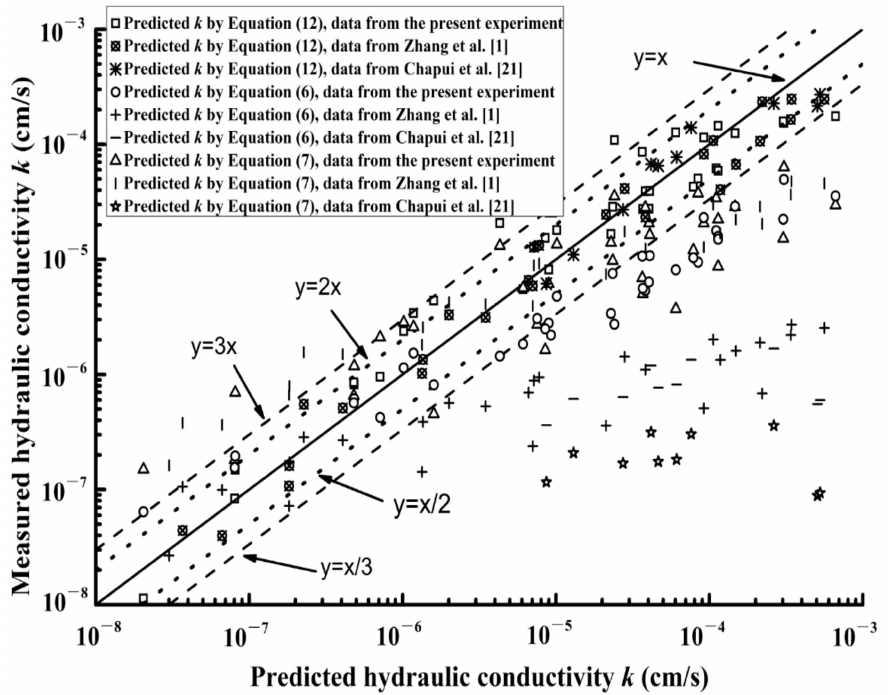
Figure 6. Computed (Equations (6), (7), and (12)) and measured hydraulic conductivity k for the data reported by Zhang et al. [1], Chapui and Robert [21], and the present study. It can be seen that Equation (12) performs better than Equations (6) and